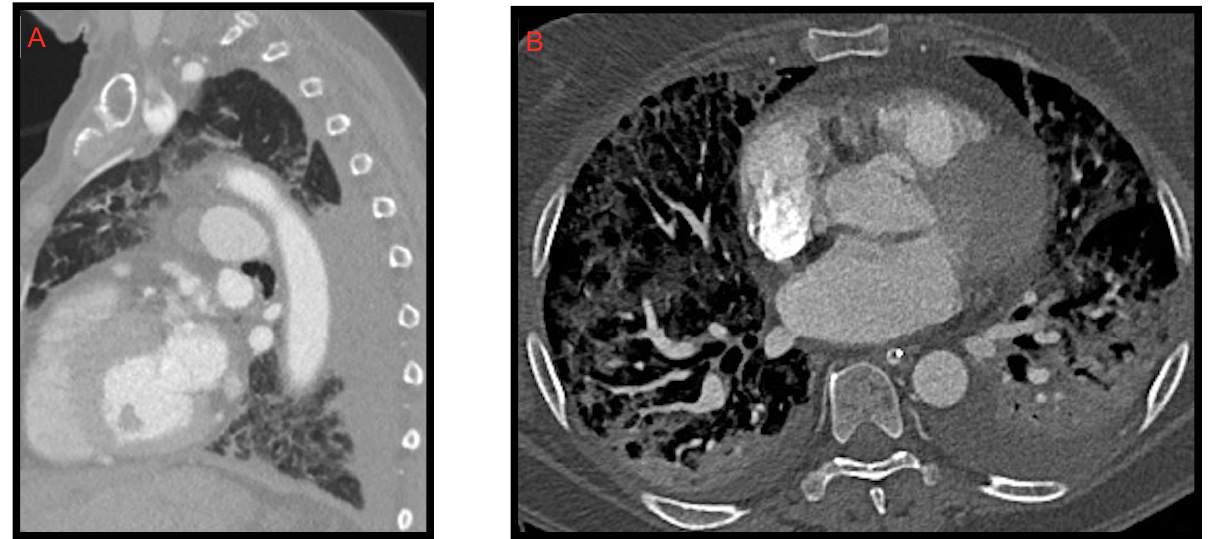
Figure 3. A 58-year-old female patient with worsening respiratory function on the 10th day of hospitalization evaluated with CT. Sagittal ( A ) and axial ( B ) images show posterior pleural effusion greater on the left side.